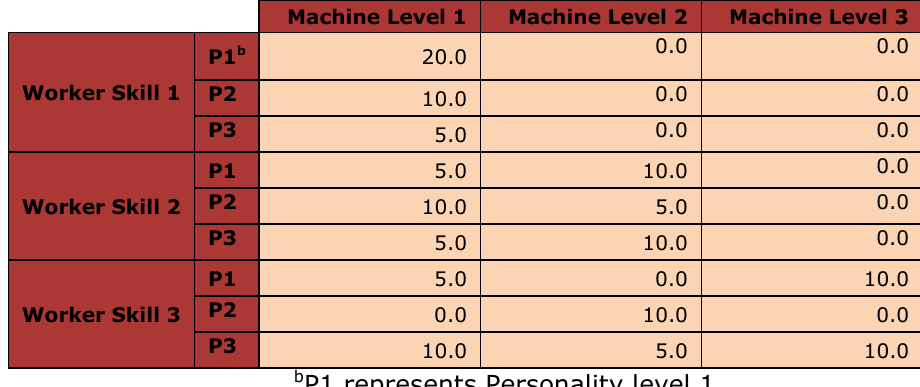
Table 4. Initial Workforce Available in Each Machine Level (workers)